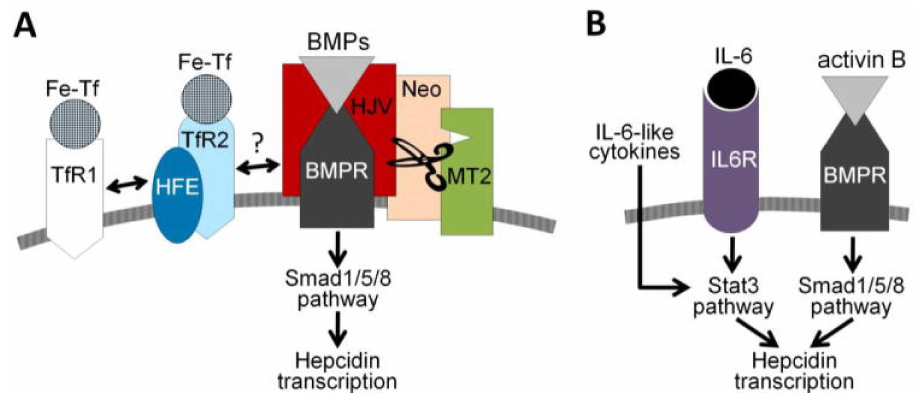
Figure 3. Regulation of hepcidin transcription. ( A ) Hepcidin regulation by the extracellular iron. ( B ) Hepcidin regulation by inflammation. Reproduced with permission after Ruchala et al., 2014 [25]. Iron levels begin a feedback loop in which TfRs are passed through to be up- or downregulated. There are two TfR isoforms, namely, TfR1 and TfR2. The former is part